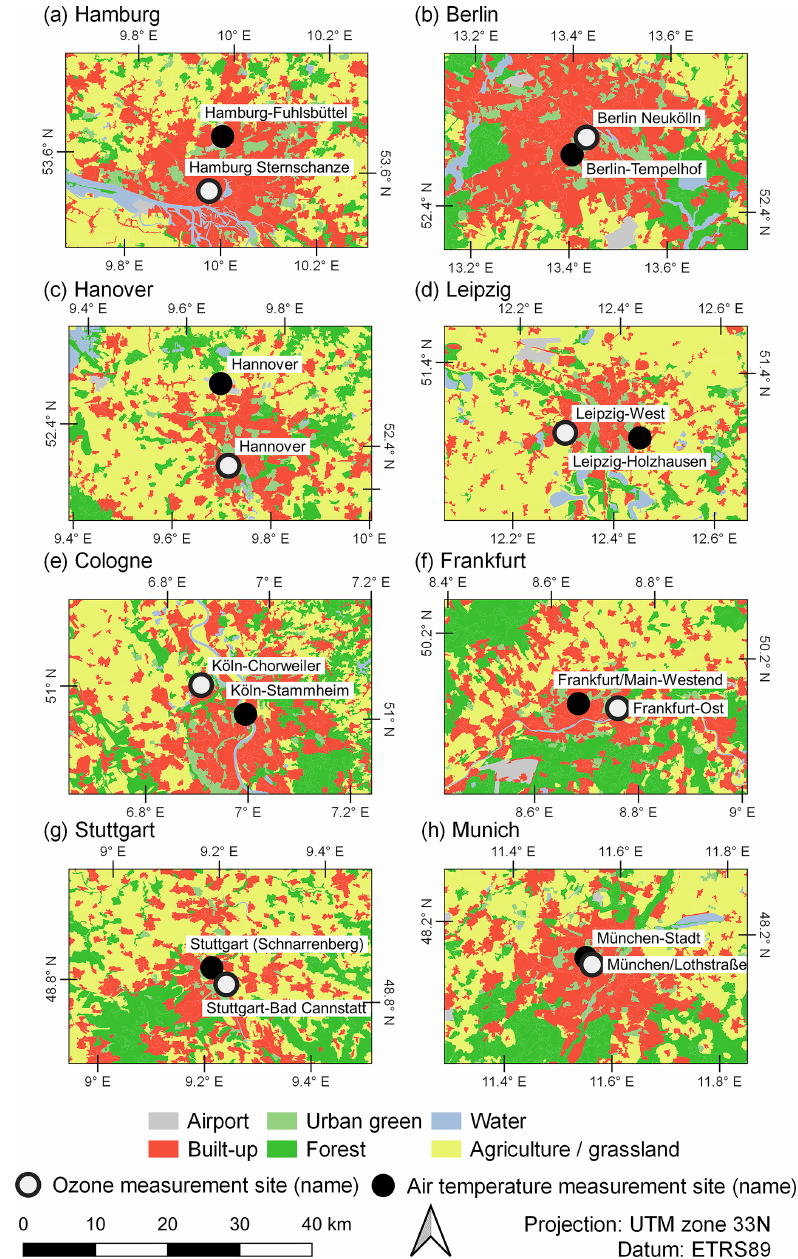
Figure A1. Location of selected air temperature and ozone measurement sites in the investigated cities. Land cover classification is based on CORINE 2018, v20 (EEA,